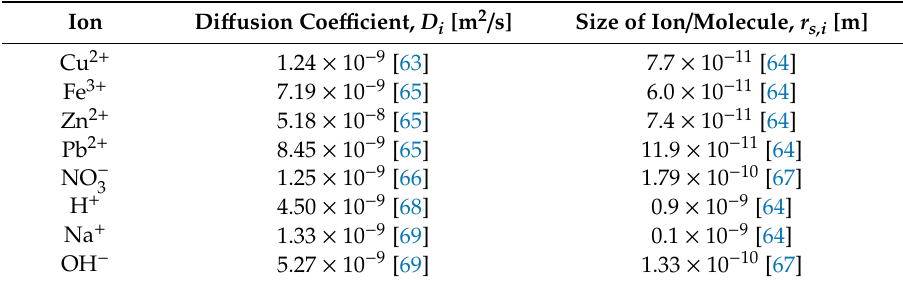
Table 3. Values of di ff usion coe ffi cients and size of ions.